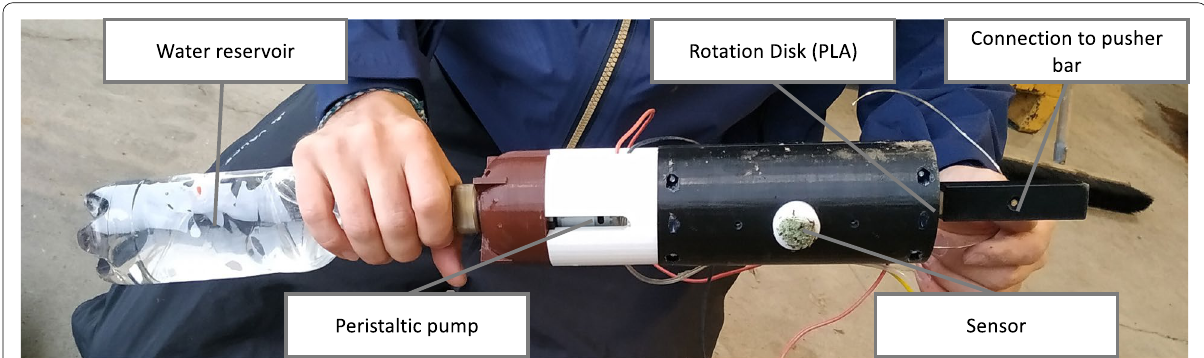
Fig. 6 Assembled prototype of the probe head for the field experiment with the peristaltic pump and the PET bottle as a water reservoir before the insertion in the protection